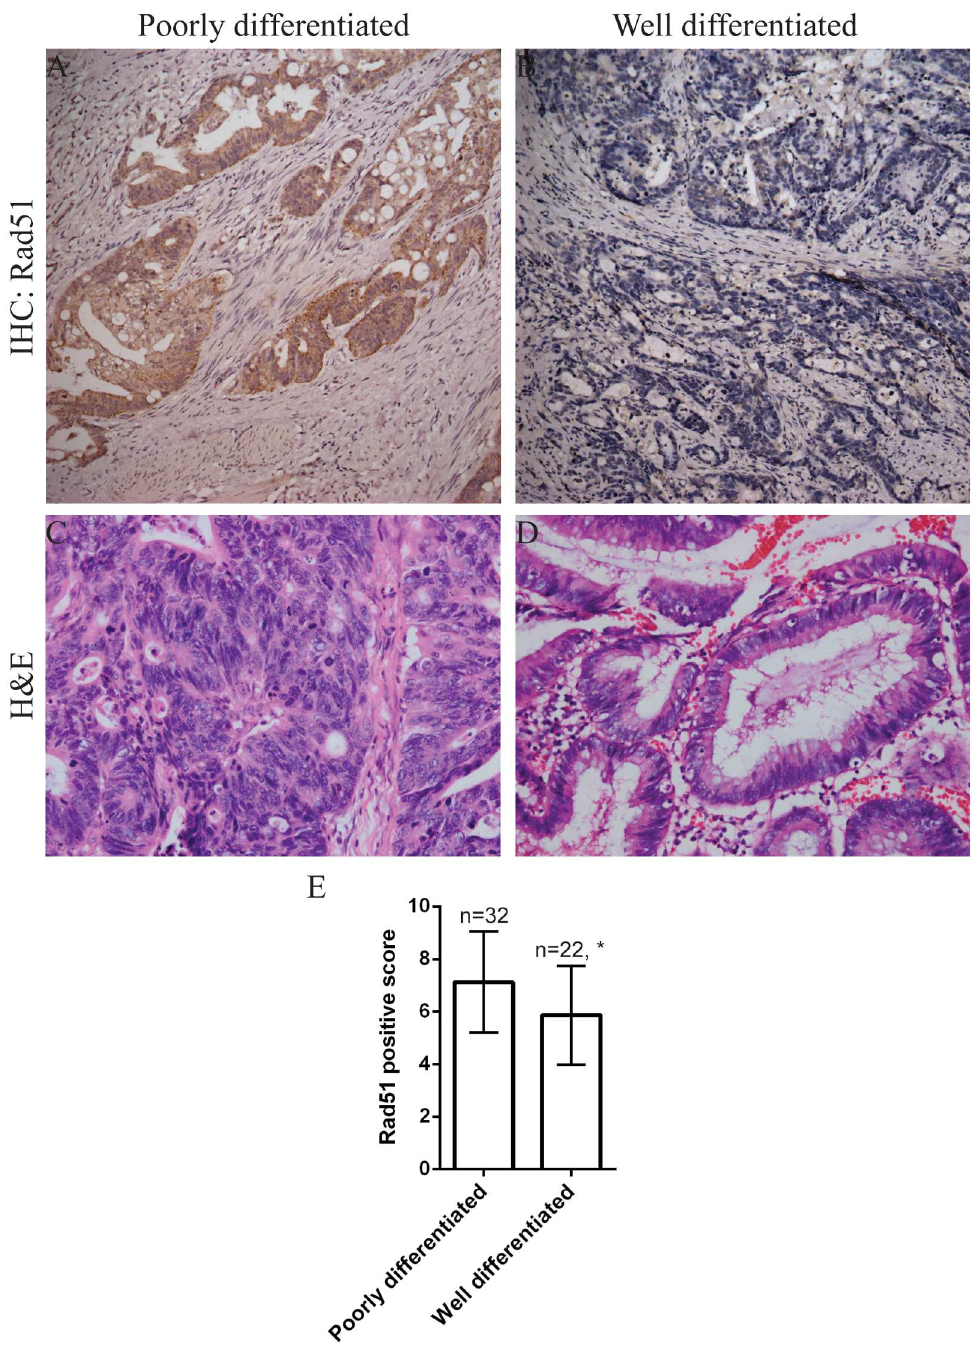
Fig 2. Immunohistochemical analysis of Rad51 expressionin CRC tissues. ( A) Rad51 was overexpressed in a poorly differentiated CRC. Cells with positive Rad51expressionshowedyellow, buffy and brown granulesin the nuclei.( B) Rad51staining was negativein a well differentiated CRC. ( C) H&E stainingof a poorly differentiatedCRC. ( D) H&E staining of a well differentiated CRC. Representative images with original magnification at 200X. (E) Quantitationof Rad51expressionin poorly differentiated versus well differentiated tumors. * p =